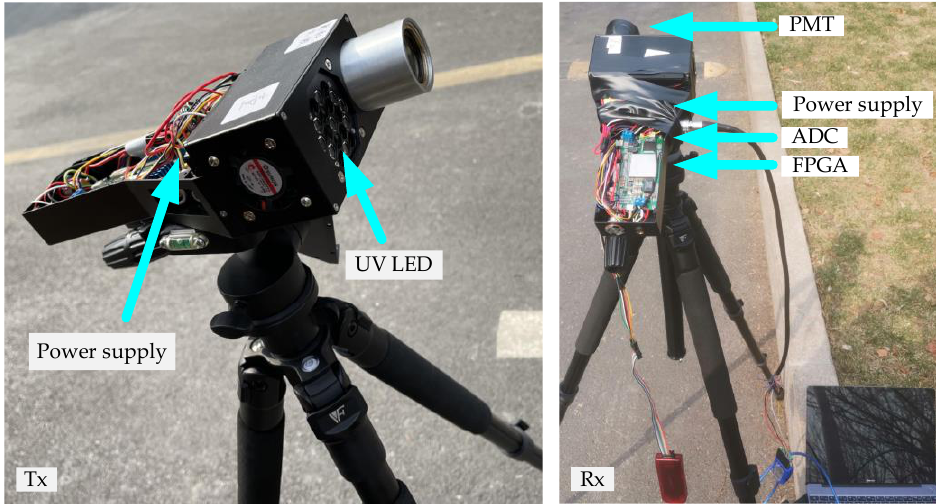
Figure 5. Outdoor NLOS UV communication test platform. Table 1. Selection of key parameters of the UV